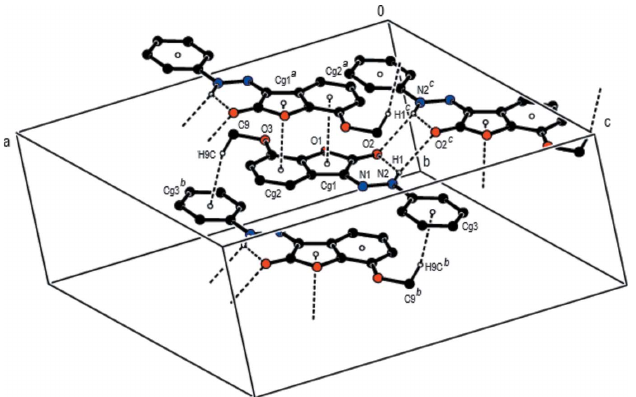
Figure 2 Intermolecular N—H (cid:2)(cid:2)(cid:2) O hydrogen bonds, C—H (cid:2)(cid:2)(cid:2) (cid:2) interactions and (cid:2) – (cid:2) stacking interactions (shown as dashed lines) in the title compound. [Symmetry codes: ( a ) 1 (cid:4) x , (cid:4) y , 1 (cid:4) z ; ( b ) 1 (cid:4) x , 1 (cid:4) y , 1 (cid:4) z ; ( c ) 1 1 (cid:4) y , 1 (cid:4) z ]. 2